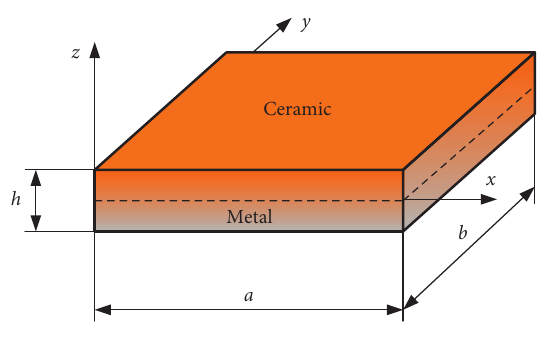
Figure 1: A model of an FGM